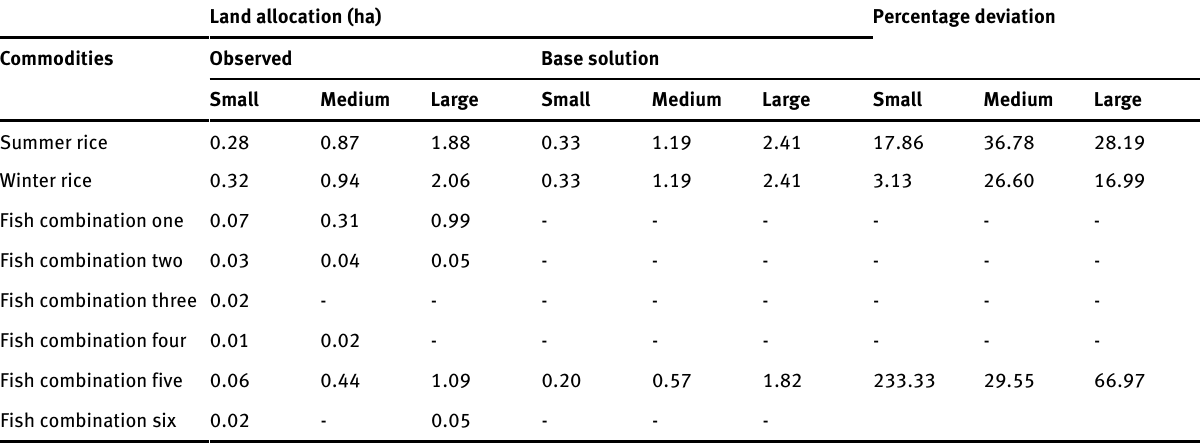
Table 4: Land allocation pattern in observed and base solution